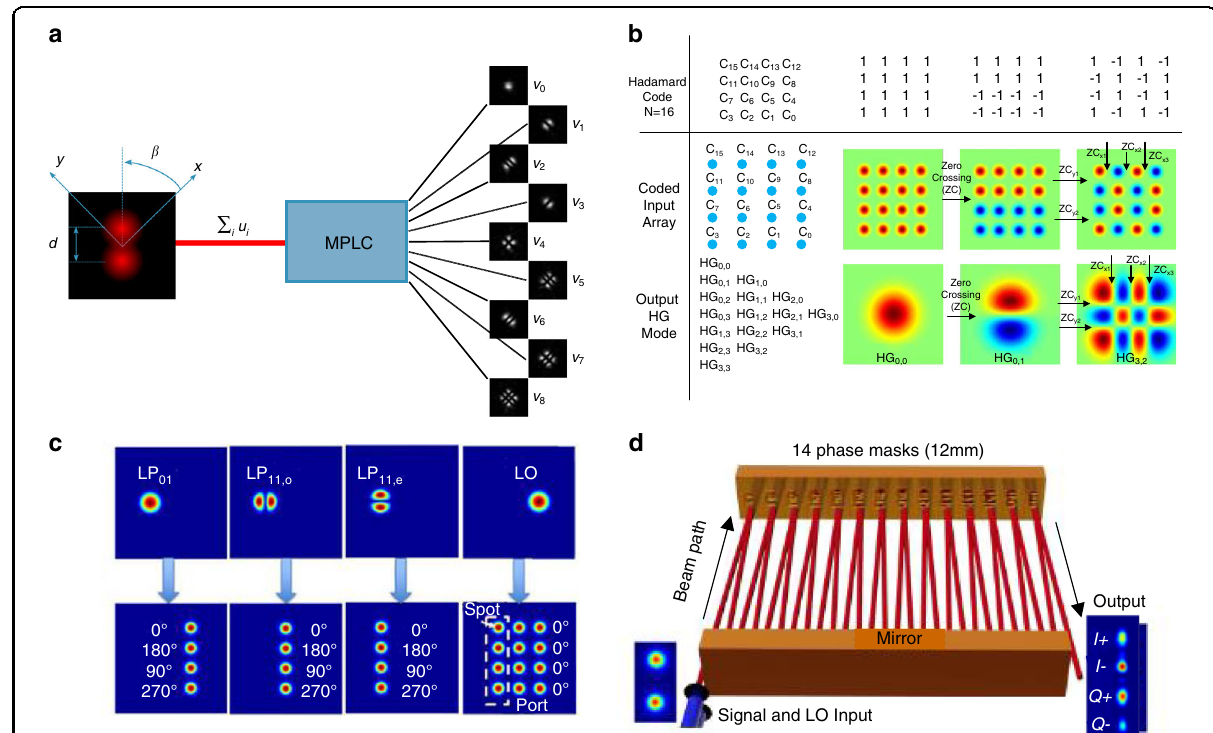
Fig. 4 MPLC-MVMs for optical signal processing. a Transverse distance estimation 97 . b Nonmode selective Hermite – Gaussian mode multiplexer 98 . c Mode demultiplexing hybrid 100 . d Ultrabroadband polarization-insensitive optical hybrid 57 . a Reprinted with permission from ref. 97 © The Optical Society. b Reproduced from ref. 98 with the permission of Chinese Laser Press. c Reproduced from ref. 100 with the permission of Chinese Laser Press. d Reprinted from ref. 57 with the permission of IEEE